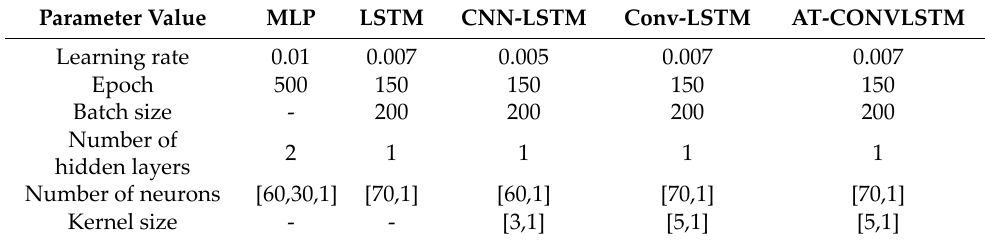
Figure 6. One testing sample in FD001 with data of 14 sensors within a time window of length 60. Table 2. Parameter settings for each network.